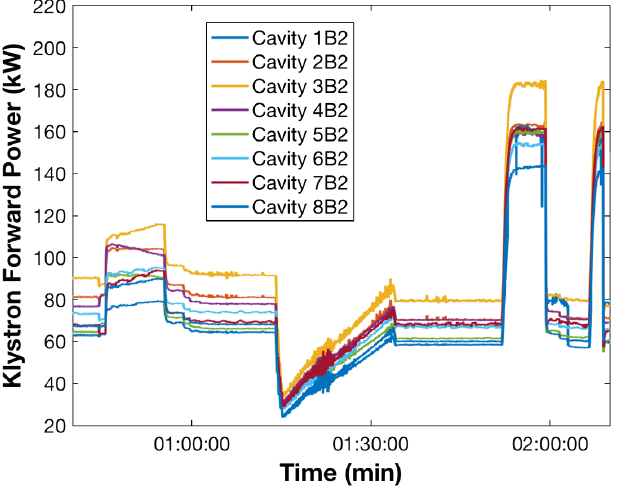
FIG. 12. Klystron forward power per turn. 204 bunches, beam 1.